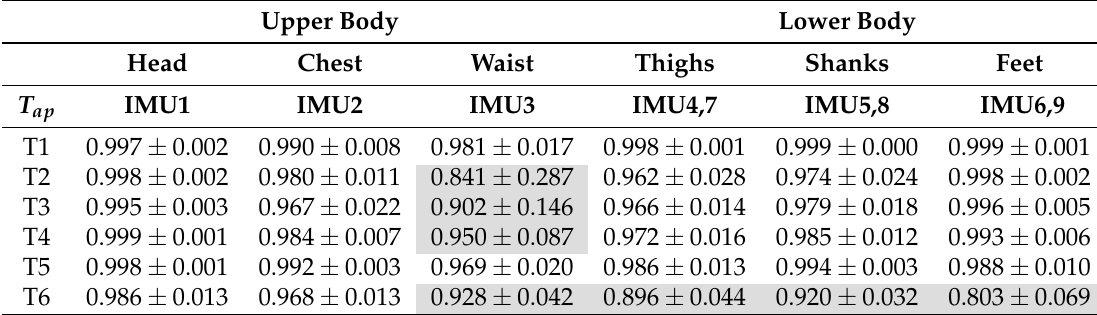
Table 3. Averaged correlation between sensors on frontal/back and lateral side of the body.